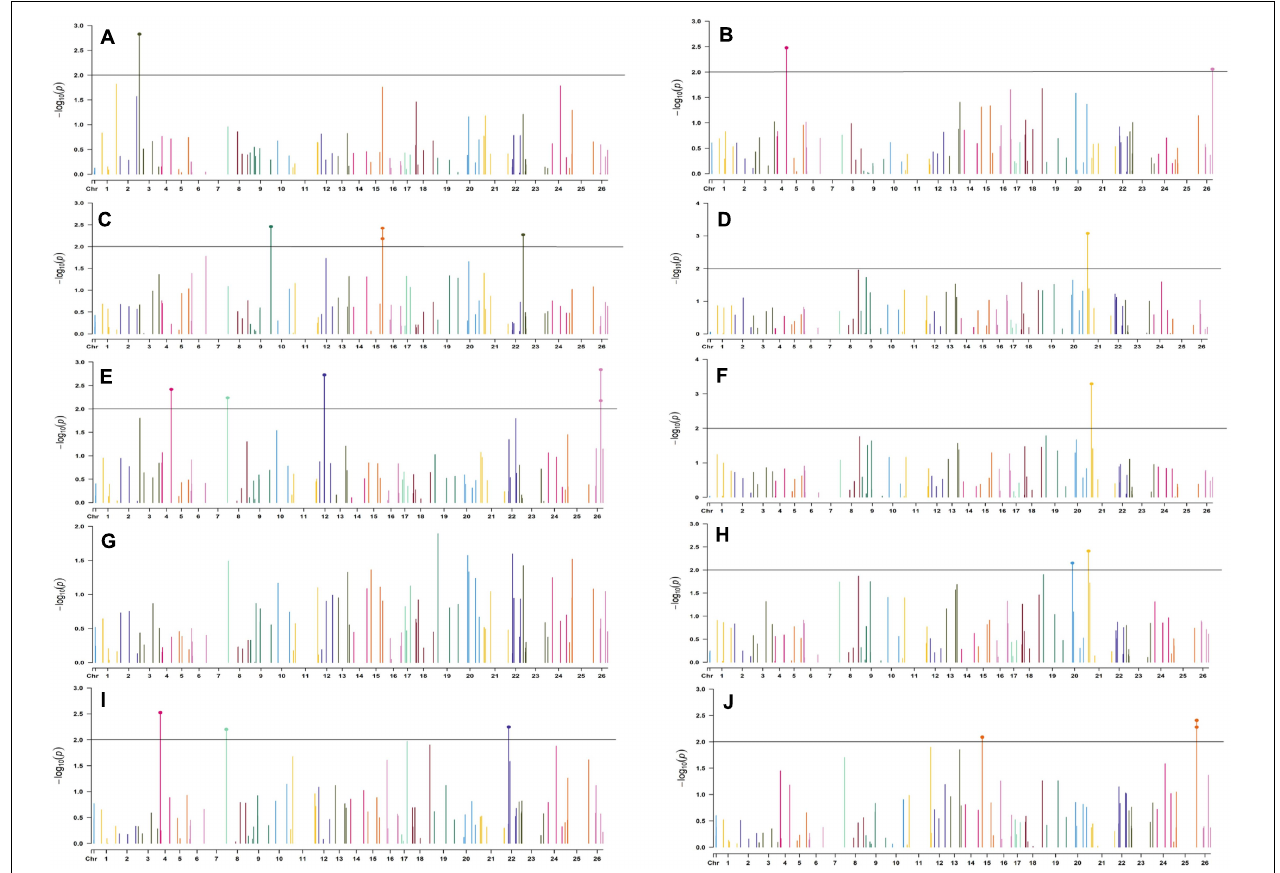
FIGURE 6 | Manhattan plots for the early sown environment of 2019 for various traits under study by the MLMM model. Significant marker above threshold {at –log10 ( p ) > 2} is highlighted with bold dot head on the marker’s line. (A) Days to first flower, (B) plant height, (C) number of monopods, (D) number of bolls